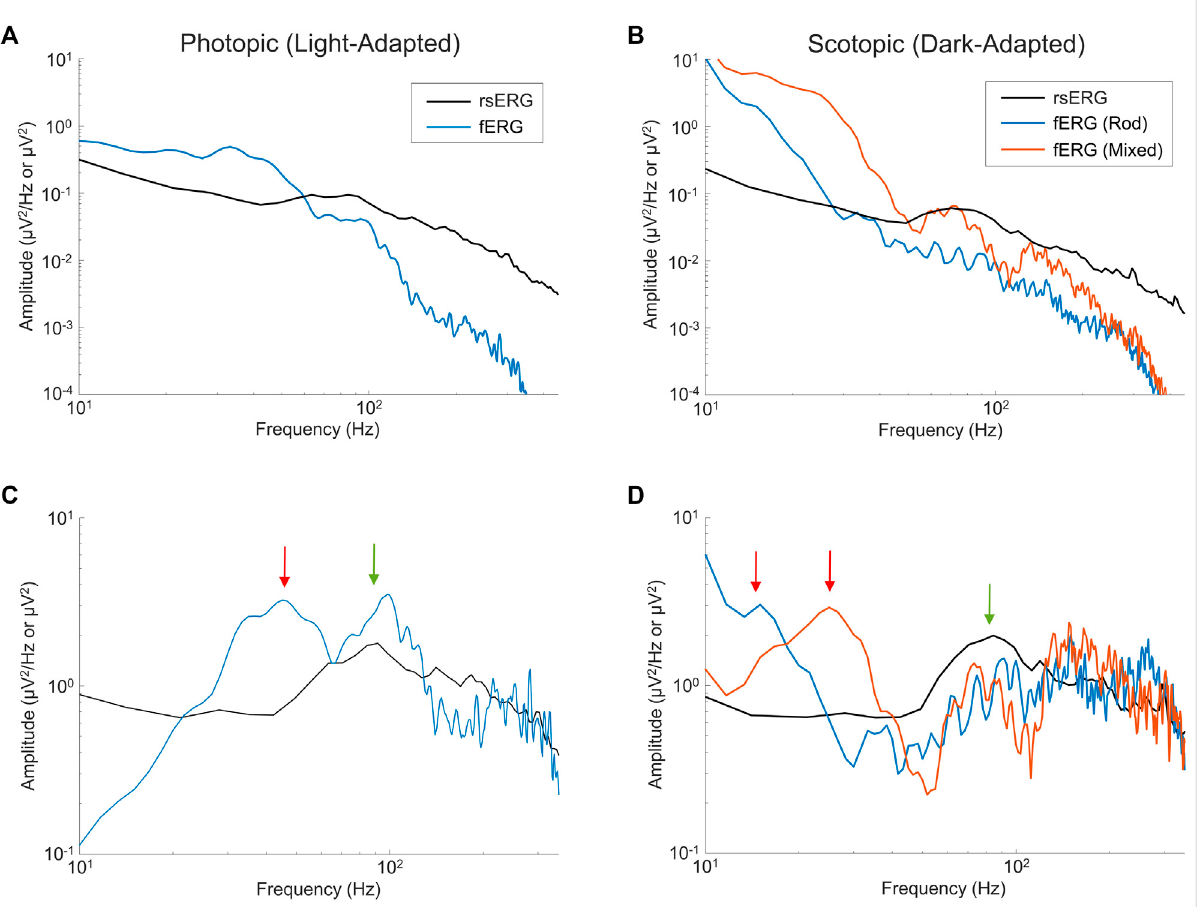
FIGURE 5 Comparing fERGs to rsERGs. Mean frequency spectrums depicted on a log-log scale for light- (A,C) and dark-adapted (B,D) rsERG and fERG signals. Of note, thefERGsignal amplitudeswere divided by10 for better visualcomparisonsin (A,B) .Noteadifference betweenthersERGand fERG frequency spectrum units (µV/Hz vs. µV), as 2 different techniqueswere used (as explained in the methods). (A,B) Original spectrums. (C,D) Modi fi ed spectrums (zoomed), with the 1/ f α background activity removed. Red arrows show peaks at low frequencies (about 15 – 45 Hz) present only in the fERGs, while green arrows show peaks at higher frequencies (about 80 – 120 Hz) present in both rsERGs and